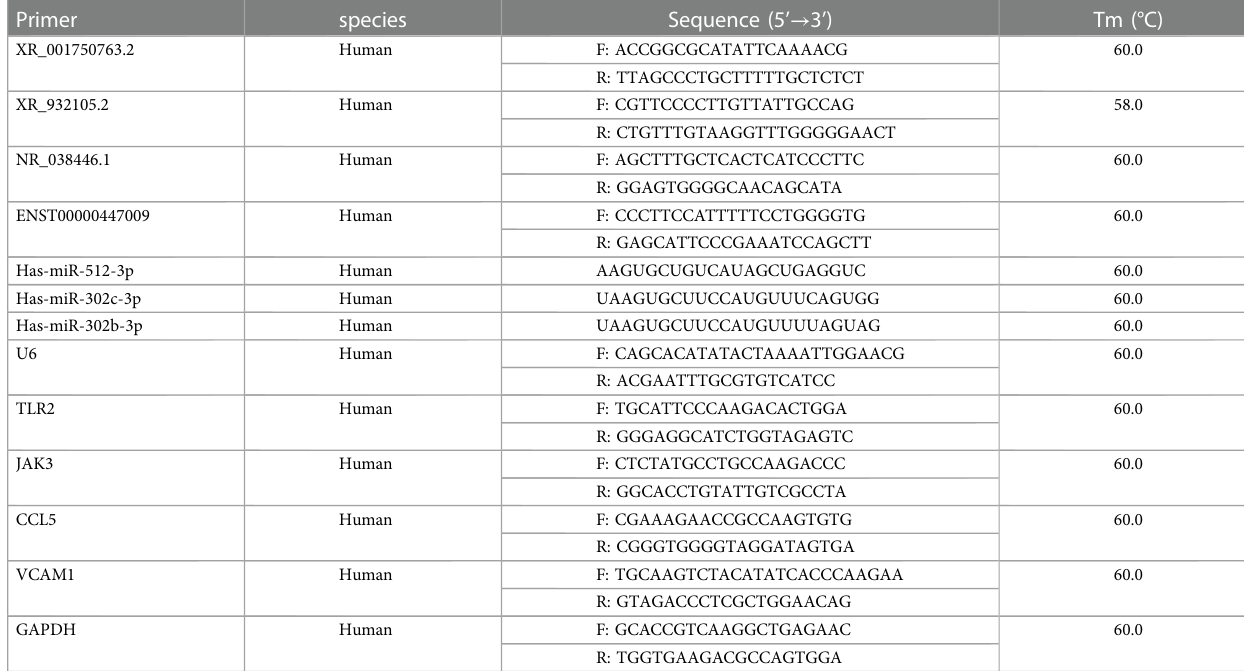
TABLE 2 Comparison of clinical characteristics between the two groups.